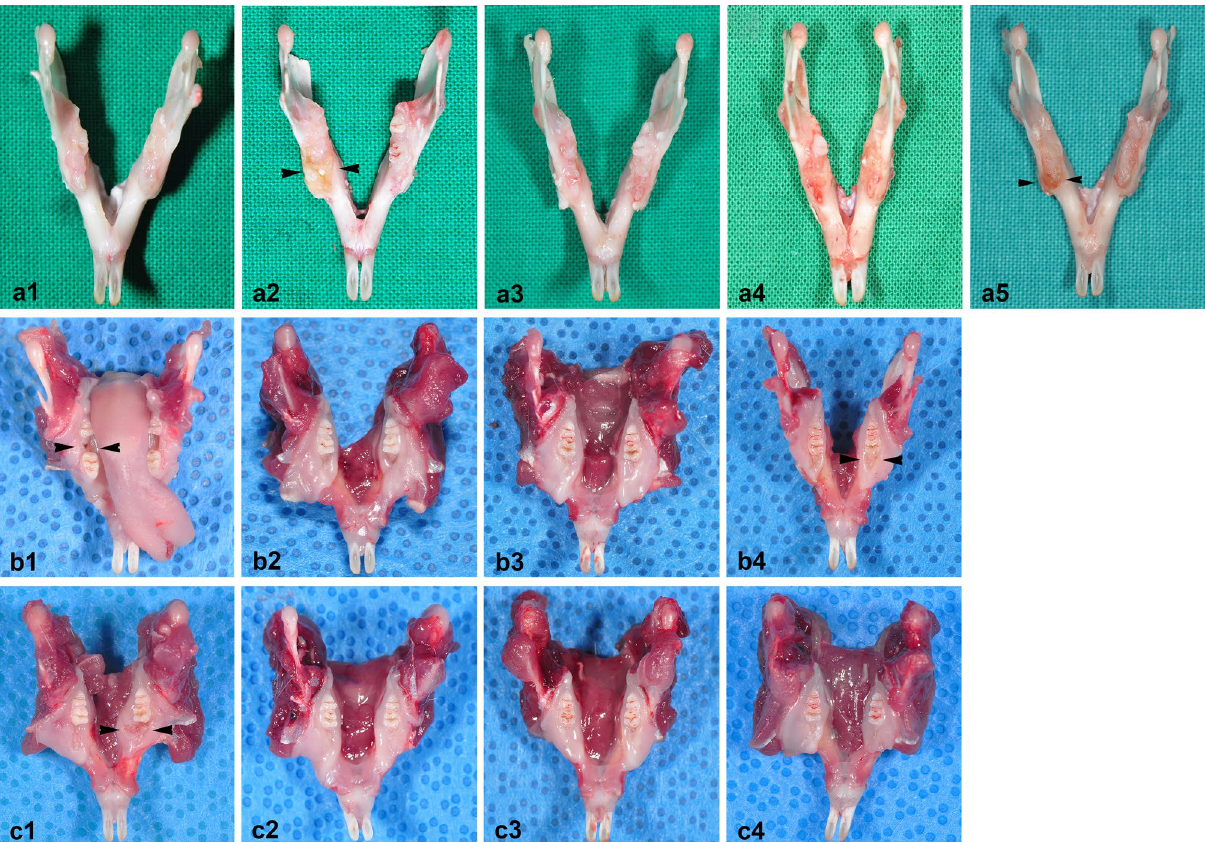
Figure 3. Clinical views of specimens obtained from the PO BRONJ model. Uneventful healing was observed in group 1 ( a1 ). In the clinical view of group 2, inflamed tissue can be seen in the extraction socket area (arrowheads) ( a2 ). In the clinical view of group 3, the extraction socket was fully healed, with irregular tissue formations compared with the control group ( a3 ). In group 4, wound healing on the extraction socket is visible, but the retained root can also be seen ( a4 ). In group 5, inflamed tissue is visible on the extraction socket (arrowheads) ( a5 ). Clinical views of specimens obtained from the IP BRONJ model. The specimens obtained from group I ( b1 – b4 ). Two weeks post-extraction, exposed necrotic bone was observed (arrowheads) ( b1 ). Representative clinical views at 4 weeks and 6 weeks post-extraction ( b2 , b3 ). Incomplete wound healing with dehiscence and bony exposure was observed 8 weeks post-extraction (arrowheads) ( b4 ). The specimens obtained from group II ( c1 – c4 ). The representative clinical view taken 2 weeks post-extraction reveals mucosal ulceration surrounding the extraction area (arrowheads) ( c1 ). Uneventful wound healing was observed 4, 6, and 8 weeks post-extraction ( c2 – c4 Tb.Th., mm; Tb.N., 1/mm; and Tb.Sp., mm) were compared between the control group and the experimental groups. Among the five groups, group 3 showed the highest BMD (0.887 ± 0.108 g/cm 3 ). Based on the duration of alendronate administration, the highest BMD was found in the control group (0.858 ± 0.039 g/cm 3 ), followed by the group that received 3 weeks of alendronate administration with a BP discontinuation of 1 week. However, the results do not differ significantly (Table 3). In terms of bone morphometry, group 3 had the highest BV/TV (68.989 ± 13.188%), BS/BV (16.392 ± 1.734/ mm), and Tb.N. (4.697 ± 0.693/mm), whereas group 2 had the highest BS/BV (33.378 ± 16.064/mm). Tb.Th. was highest in group 4 (0.153 ± 0.013 mm), and group 5 had the highest Tb.Sp. (0.180 ± 0.243 mm) (Table 4). Based on the duration of drug administration, the control group had the highest BV/TV (63.725 ± 5.032%) and Tb.Th. (0.149 ± 0.119 mm). Three weeks of alendronate administration with medication discontinuation for 1 week produced the highest BS/BV (29.253 ± 10.638/mm) and Tb.Sp. (0.171 ± 0.010 mm), and Tb.Sp. was lowest after 8 weeks of alendronate administration with 1-week BP discontinuation (0.122 ± 0.550 mm). Furthermore, BS/ TV and Tb.N. were highest in the group that received 8 weeks of treatment (16.392 ± 1.734/mm, 4.697 ± 0.693/ mm, respectively). However, those results do not differ significantly (Table 4). Medication discontinuation in the pamidronate intraperitoneal injection model. The statistical analysis of BMD and bone morphometry within group I showed significant differences in all parameters ( p < 0.05), whereas group II showed a significant difference only in Tb.Th. (Table 5). The overall comparison showed higher BMD, BV/TV, BS/TV, and Tb.Th. values in group I than in group II (Table 5). Over time, group I showed constant changes in BMD and bone morphometry parameters compared to group II (Fig. 5). In group I, the BMD, BV/TV, and Tb.Th.